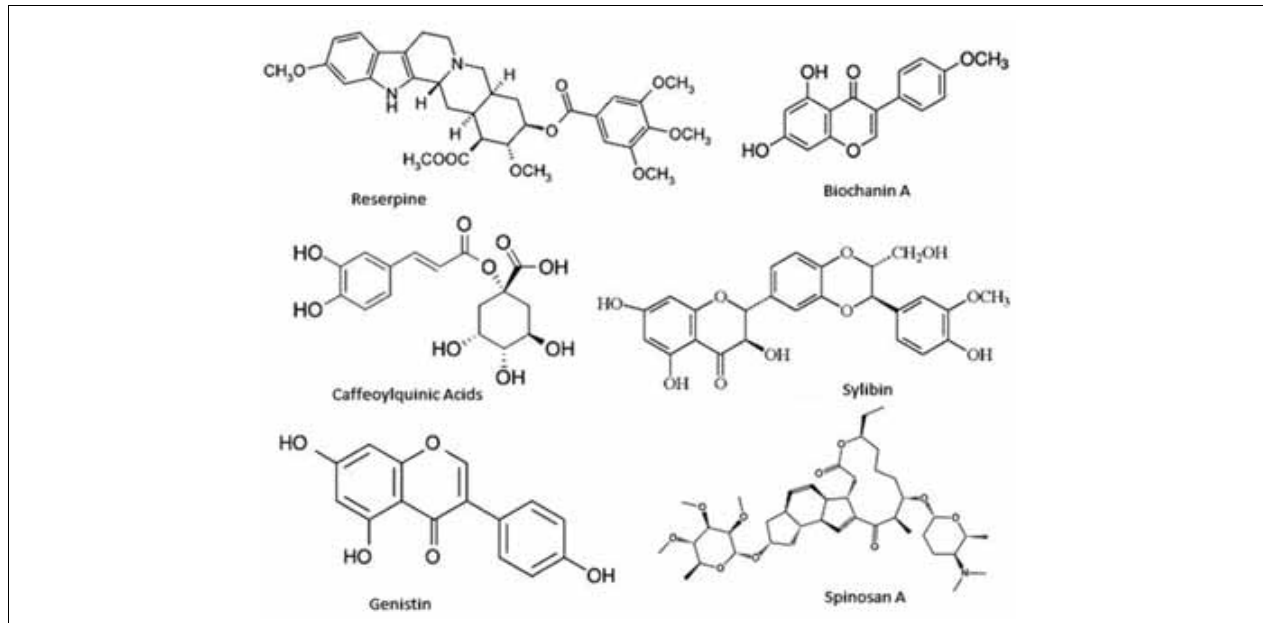
FIGURE 5 | Few representative chemical structures of efflux pump